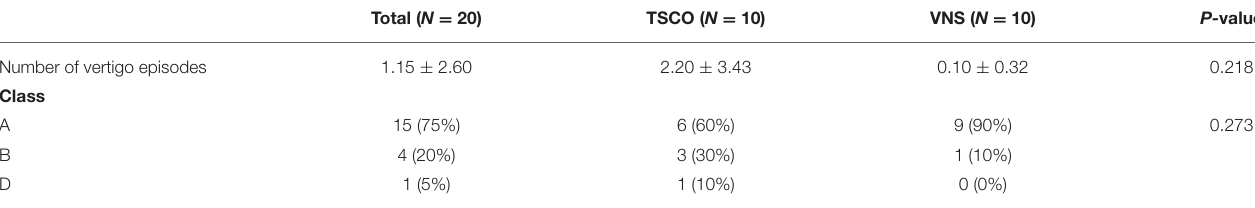
TABLE 3 | Vertigo control after surgery in all follow-up patients.